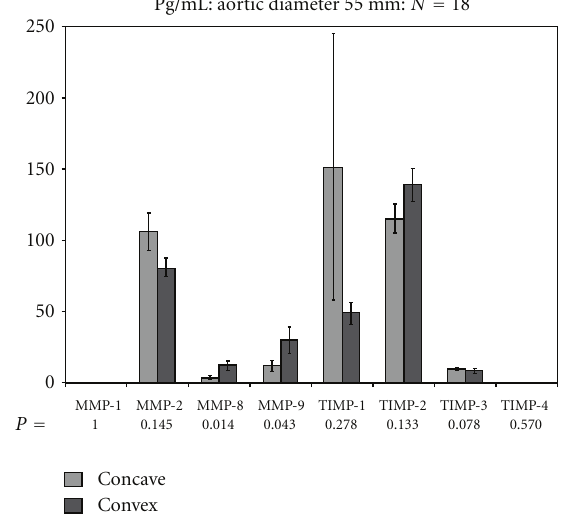
Figure 2: Detection of MMPs and TIMPs in BAV and TAV patients with aneurysms ≤ 54 mm in diameter. Figure 3: Detection of MMPs and TIMPs in BAV and TAV patients with aneurysms ≥ 55 mm in